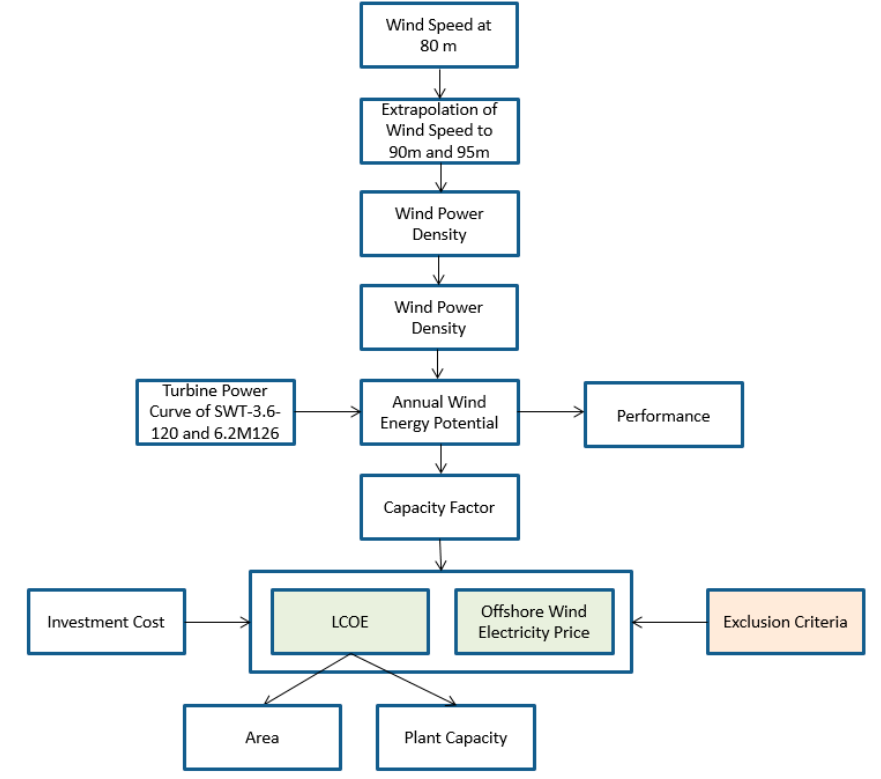
Figure 14. Detailed technical